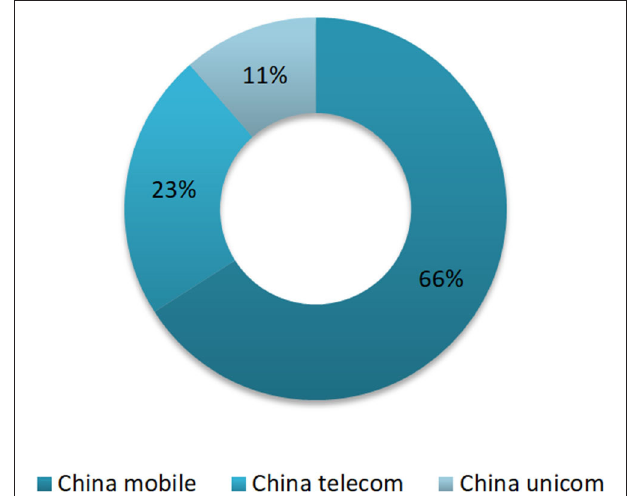
FIGURE 9 | The proportion of users of mobile